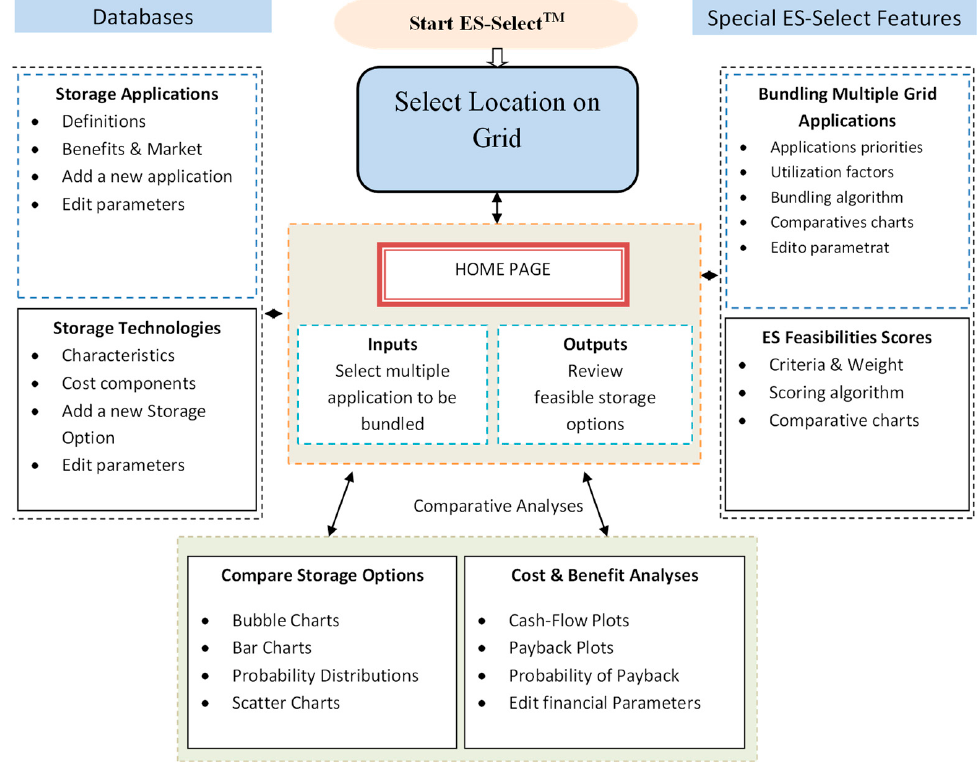
Figure 3. Overview of ES-Select™ design and functionalities adapted after KEMA [7]. Table 1. List of priority services covered by the proposed